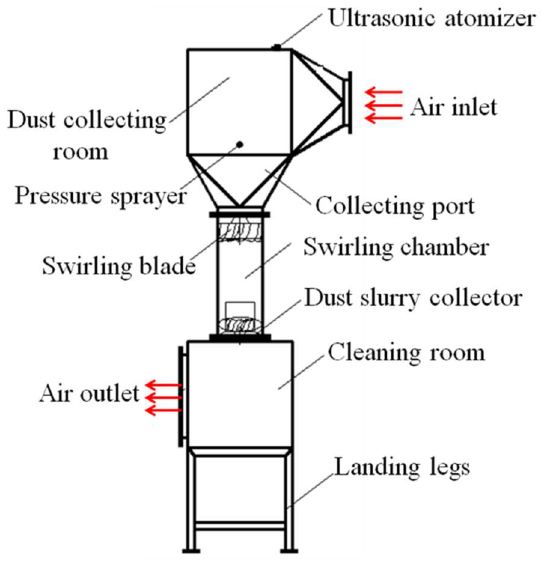
Figure 1. Illustrative diagram of the SCDC.